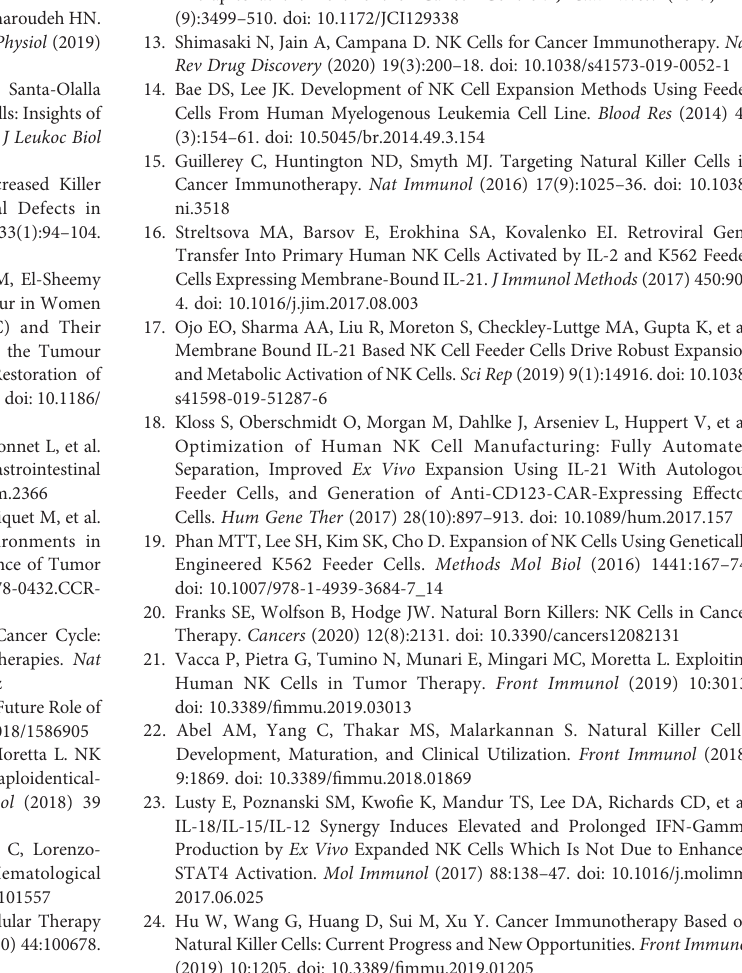
harvested and cytotoxicity was determined by calcein-release assay. n = 3 donors, ns: not signi fi cant, p > 0.05; one-way ANOVA. Supplementary Figure 2 | Changes in the proportion of NK cells, B cells, CD3 + CD8 + T cells, and CD3 + CD4 + T cells during NK activation and expansion in vitro . (A) Representative fl ow cytometry analysis of the percentage of NK cells, CD19 + B cells, CD3 + CD8 + Tcells, and CD3 + CD4 + Tcells during the course(d0, d3, d7, d14) of NK cell culture with non-coated rituximab. (B) Statistical analyses of the percentages of NK cells, CD19 + B cells, CD3 + CD8 + T cells, and CD3 + CD4 + T